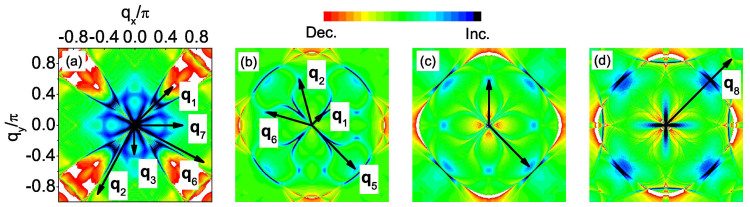
Δ|ρ↑(q, ω)|.(a): n = 5.2 and ω/Δ = −0.75. (b), (c) and (d) are all for n = 4.25, but at ω/Δ0 = 0.3, 0.4 and 0.5, respectively.